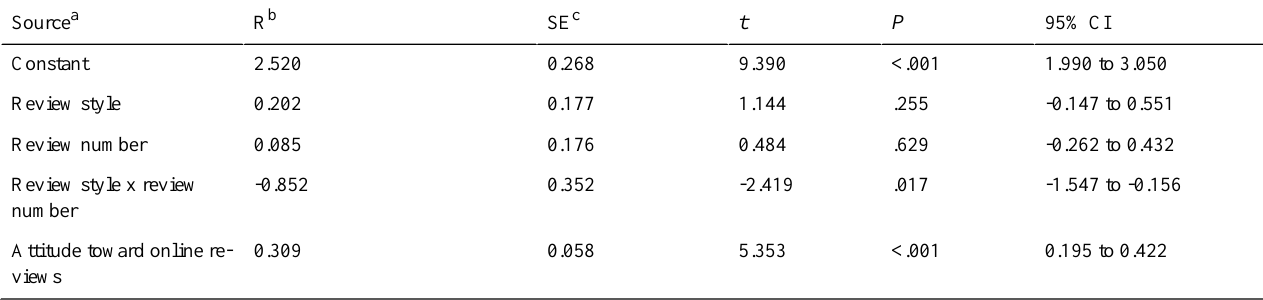
Table 4. Results of the moderated mediation analyses for the outcome variable, perceived credibility of the review.